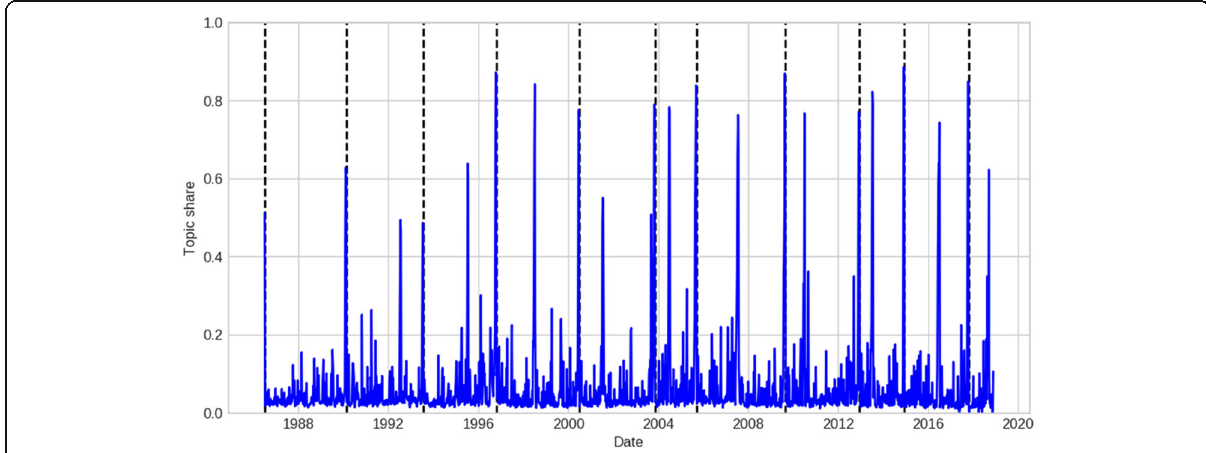
Fig. 7 Topic share of election topic 1 (last-minute election